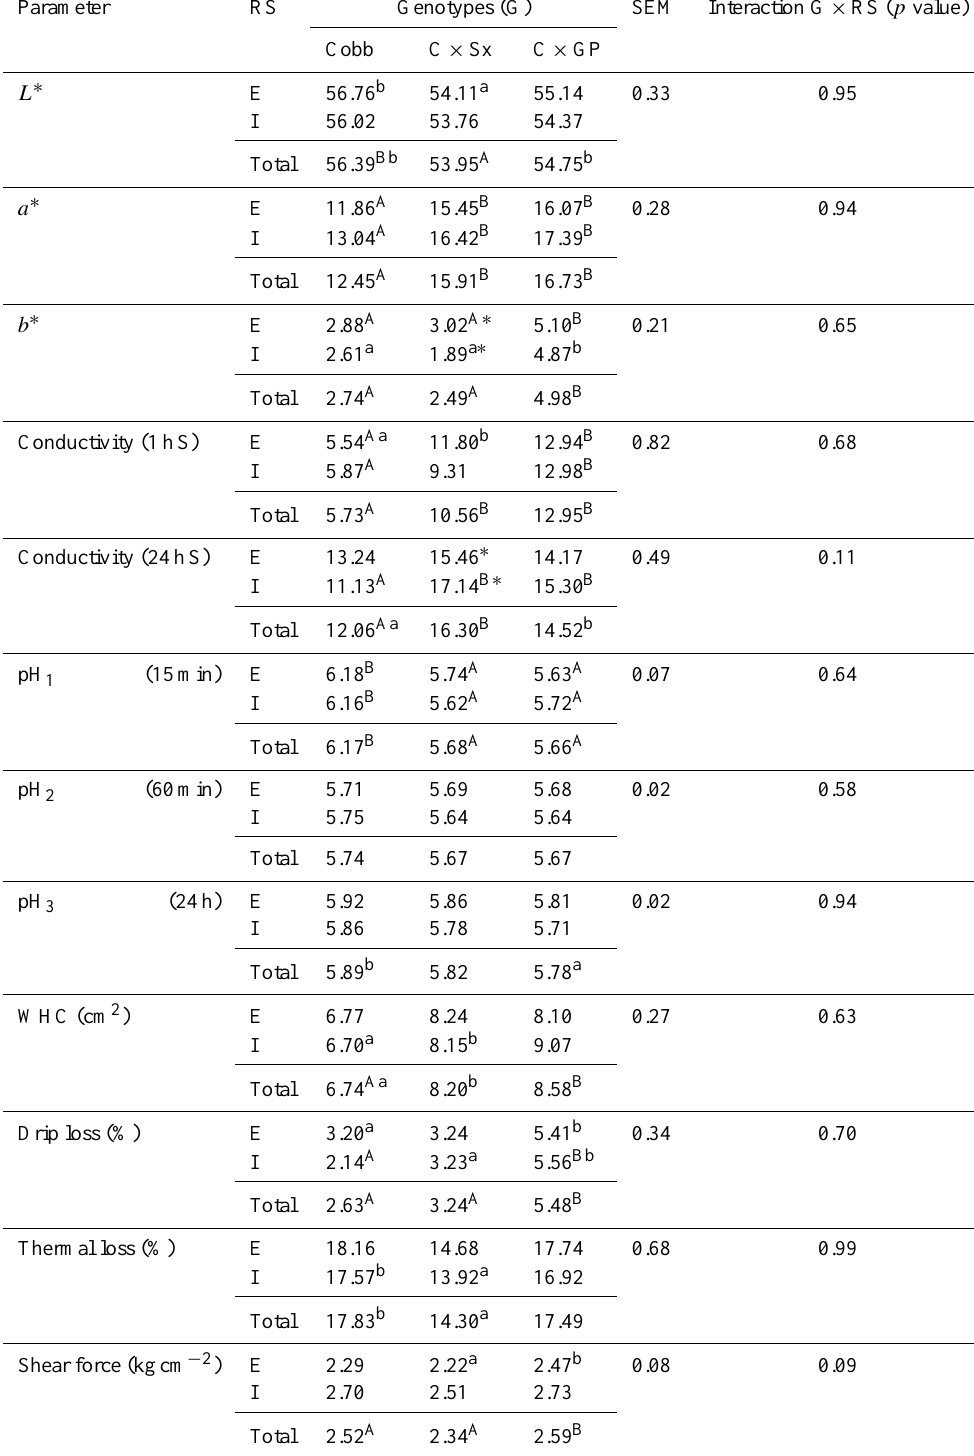
Table 6. Technological traits of meat (breast muscle).